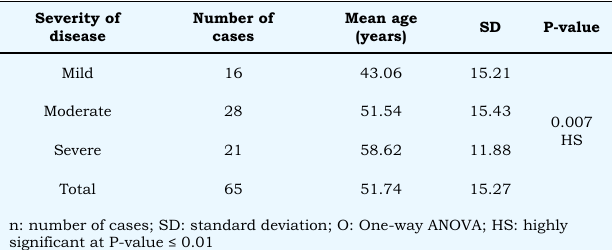
Table 3 Comparison of mean age of patients with COVID-19 according to the severity of disease Severity of disease